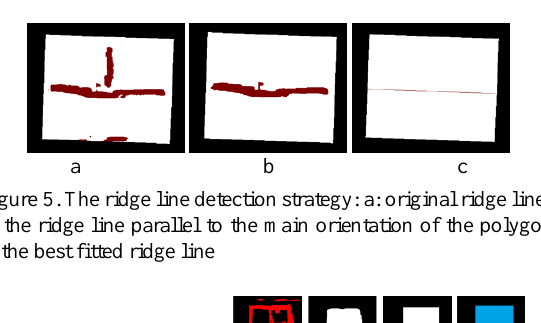
Figure 4. The rule to detect individual building roofs: a: the predicted rooflines; b: the binary polygon of eave lines; c: The approximated binary polygon, corresponding eave lines, and horizontal and vertical lines; d: individual building parts